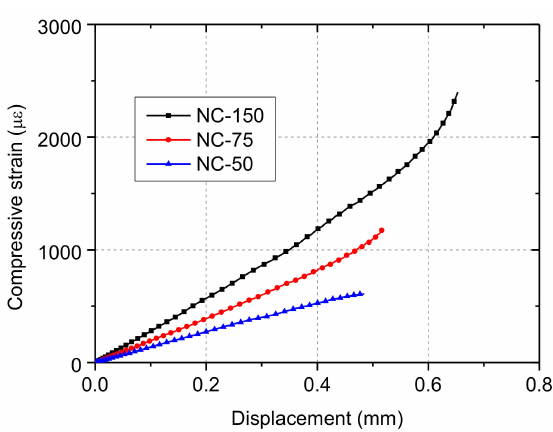
Figure 20. Displacement–compressive strain